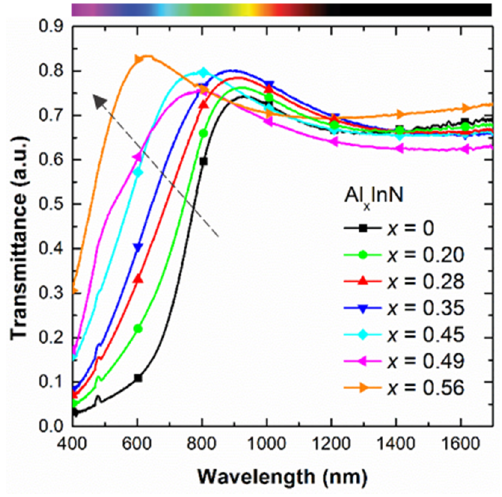
Figure 3. Optical transmission spectra of the Al x In 1 − x N on sapphire samples vs the Al mole fraction.